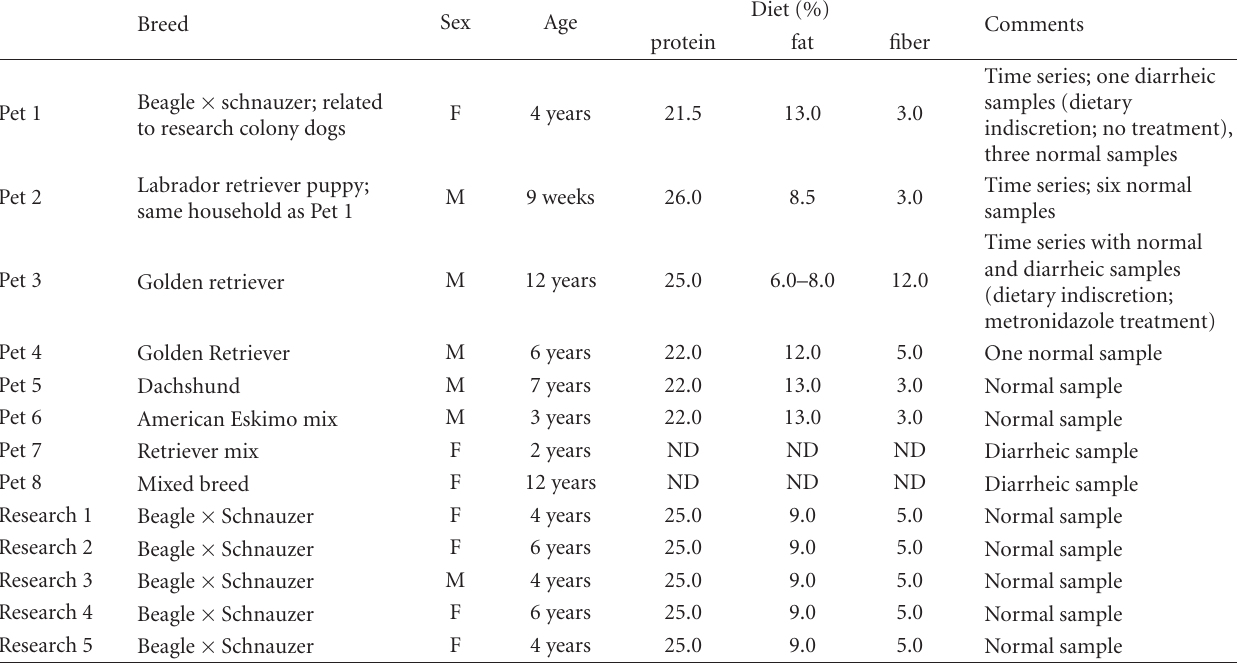
Table 1: Characteristics of dogs enrolled in the